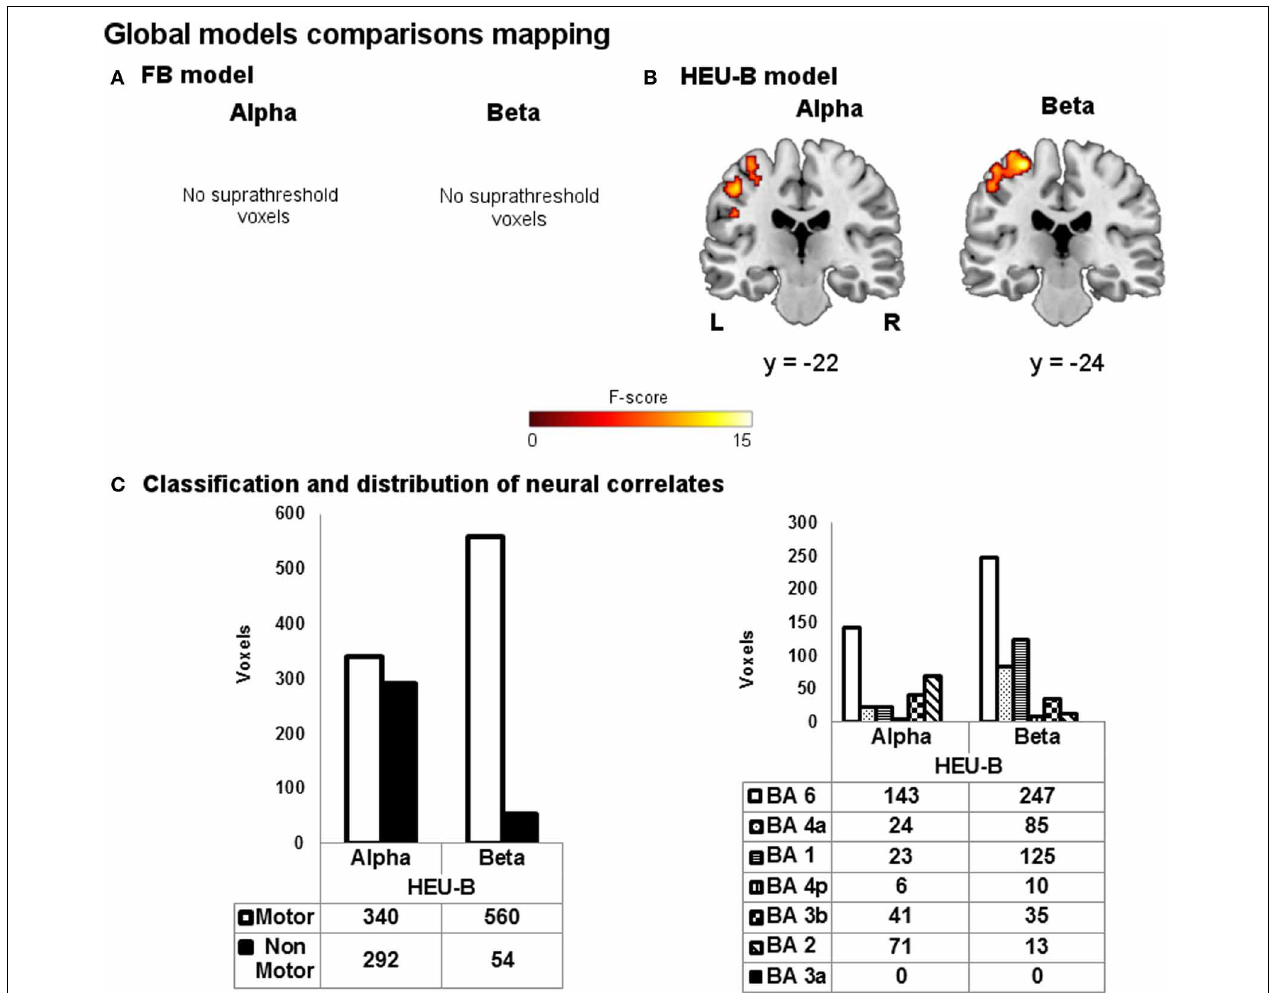
FIGURE 7 | Global models comparison mapping. Group maps showing neural correlates of alpha and beta rhythms for (A) FB and (B) HEU-B model ( p < 0 . 001, uncorrected). (C) Voxels classification according to the BAM (left);